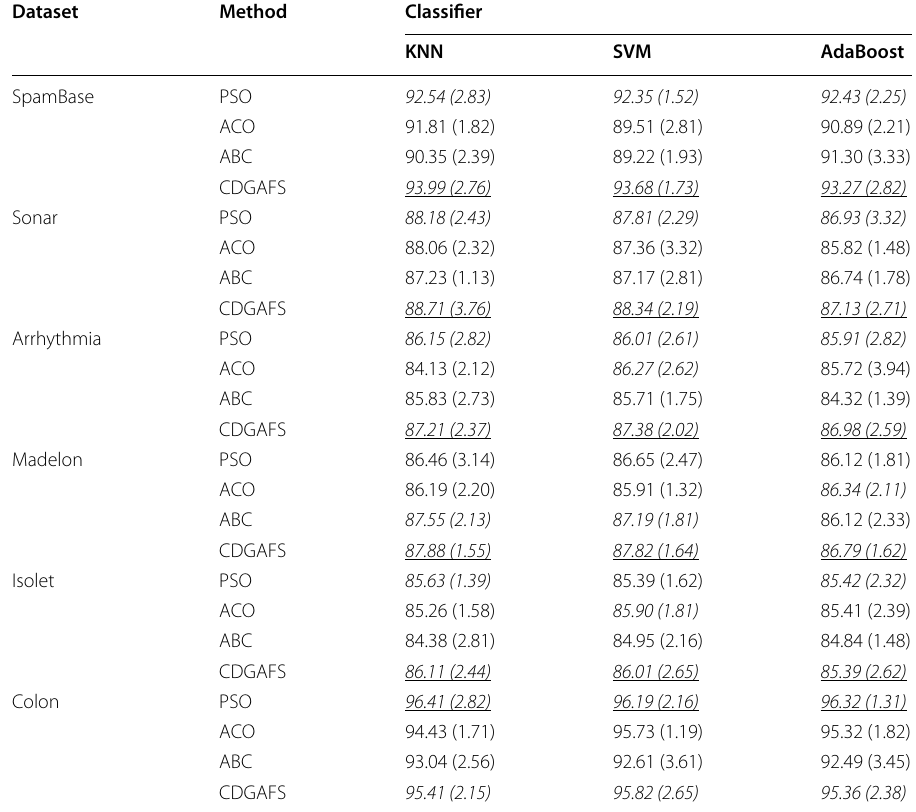
The best result is indicated in italics and underlined, and the second-best is in italics